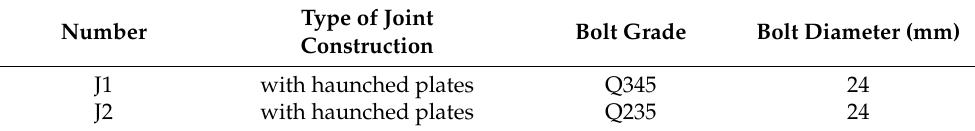
Table 2. Specimen types and